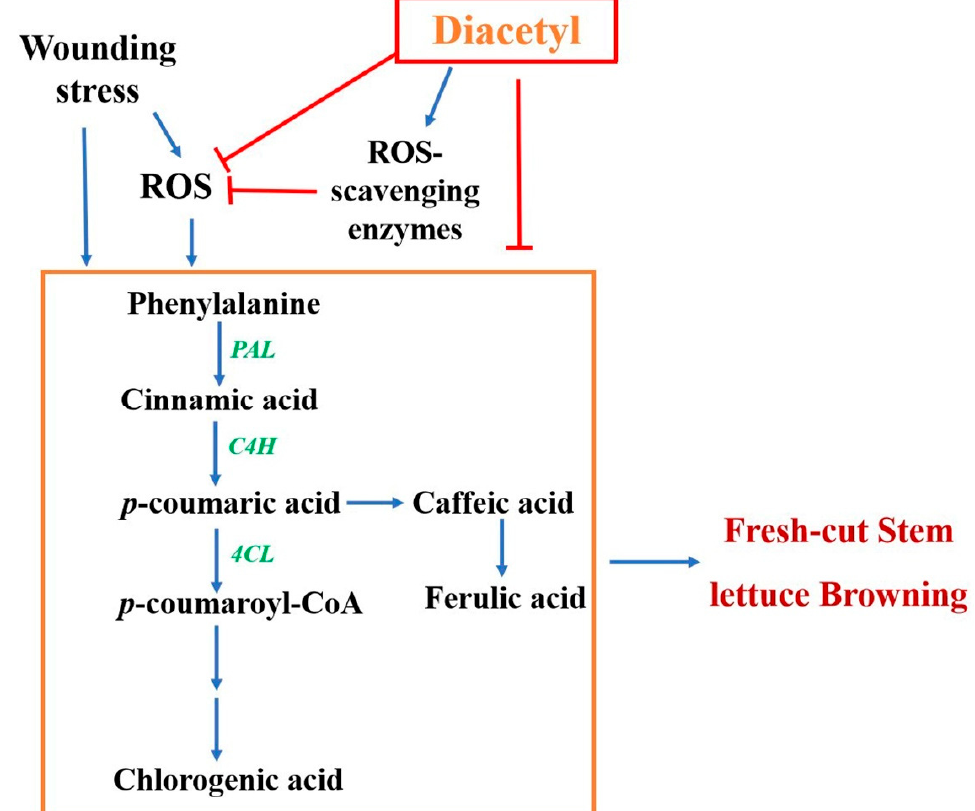
Figure 6. The diagrammatic model of the potential mechanism of diacetyl treatment regulating the browning of fresh-cut stem lettuce. The red lines represent a negative effect, while the blue lines represent a positive effect.